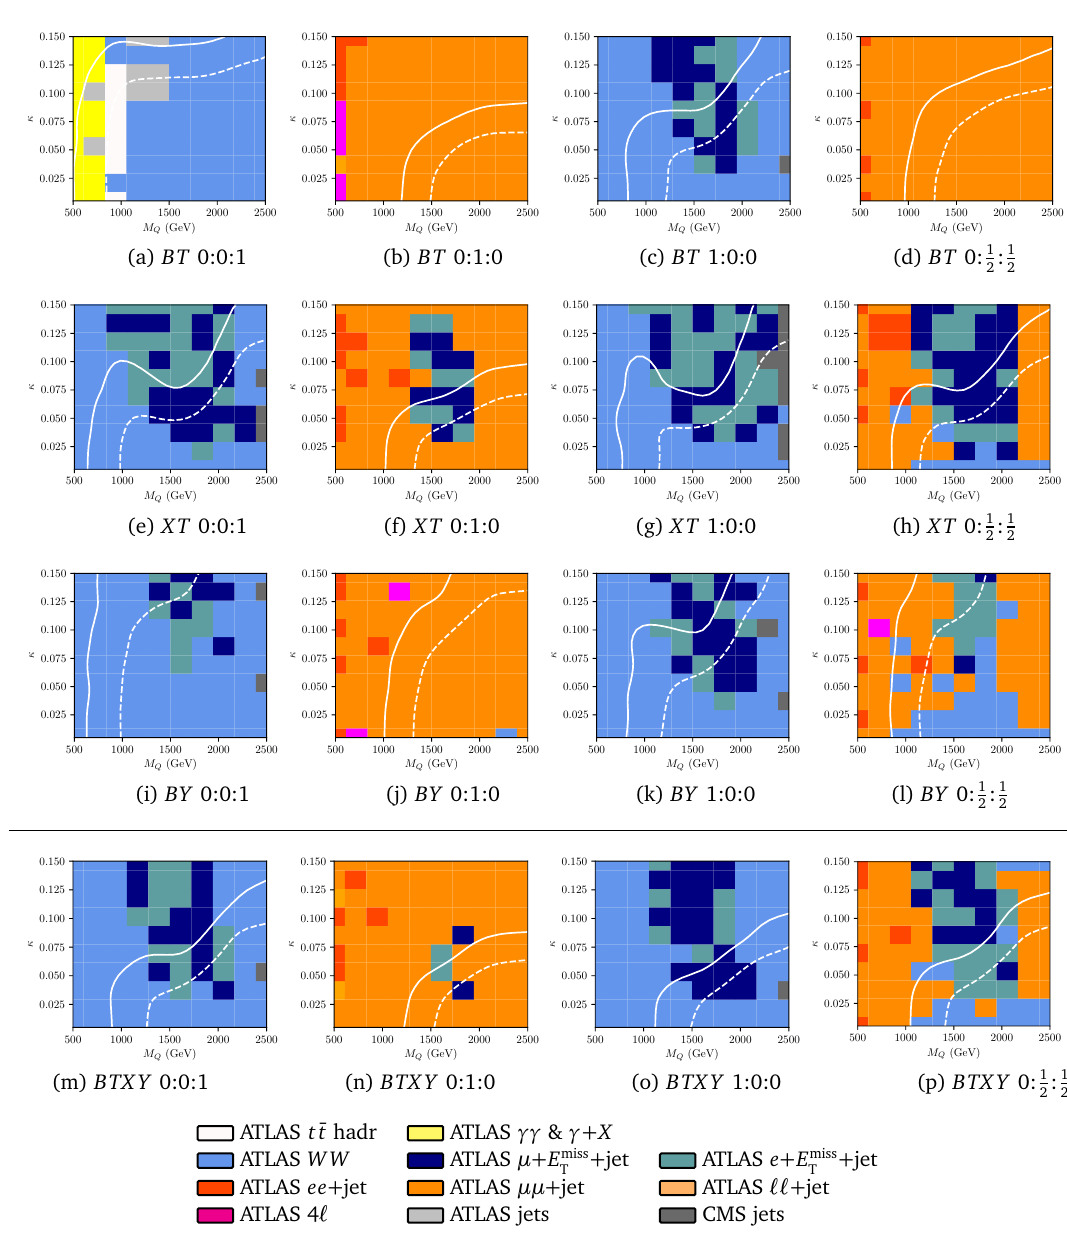
Figure 12: Sensitivity of LHC measurements to VLQ doublet production in the κ vs VLQ mass plane, where κ is the coupling to first-generation SM quarks. All VLQ masses are set to be degenerate. The multiplets are given as rows: (a)–(d)( B , T ) doublet, (e)–(h)( X , T ) doublet, (i)–(l)( B , Y ) doublet, and for comparison to the main text, the (m)–(o)( B , T , X , Y ) quadruplet. The VLQ branching fractions to W : Z : H